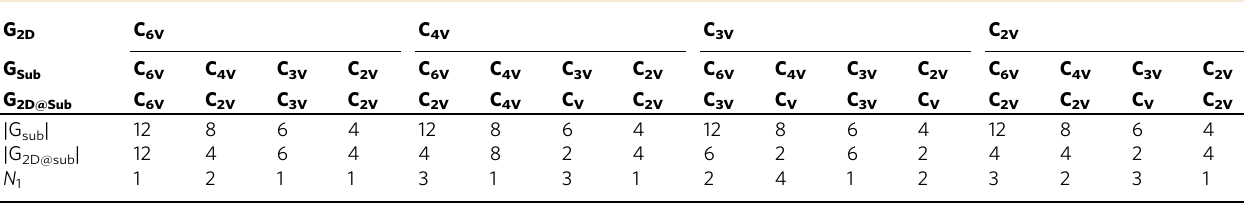
Table 1 The number of equivalent but different orientations of a 2D material on a substrate based on the interplay between their symmetries.